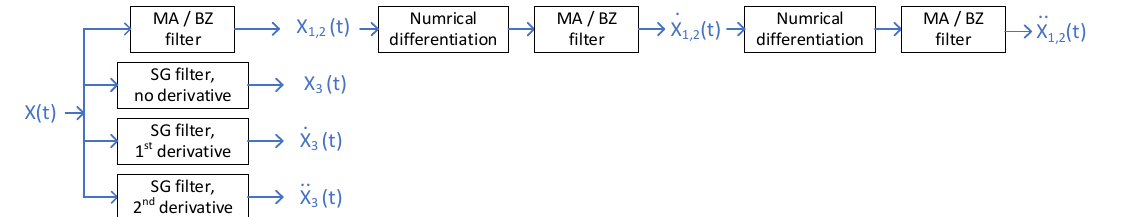
Table 2. Low pass filters characteristics.